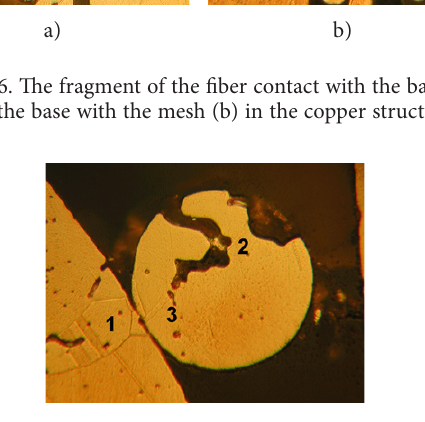
Figure 7. Effects of “ hydrogen disease”: open (2) and closed (3) pores on fibers and grain boundaries